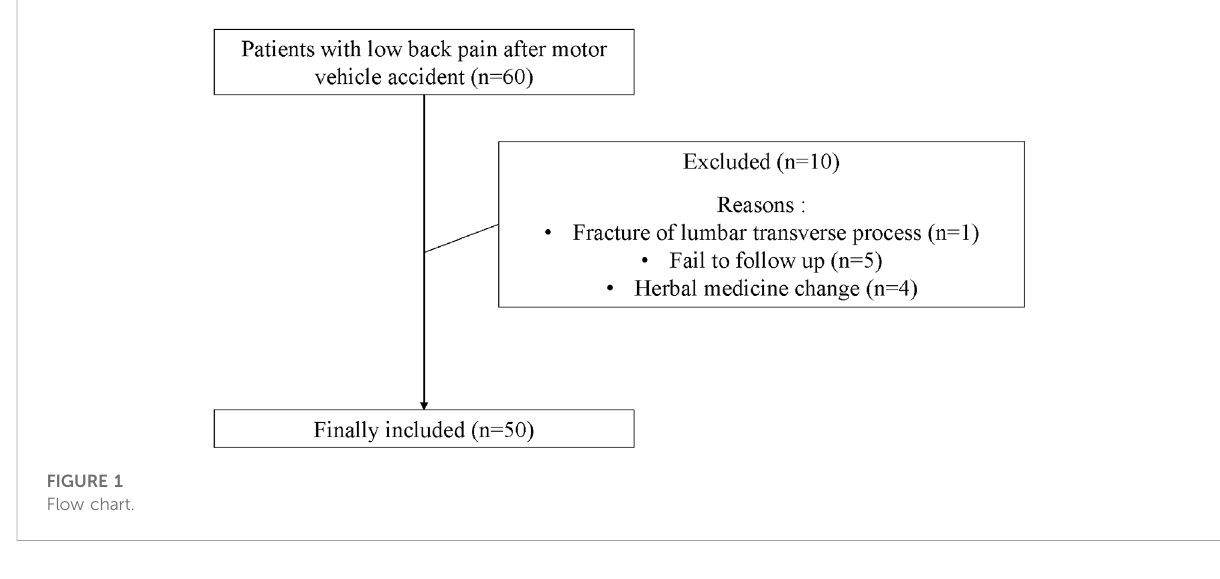
FIGURE 1 Flow chart.